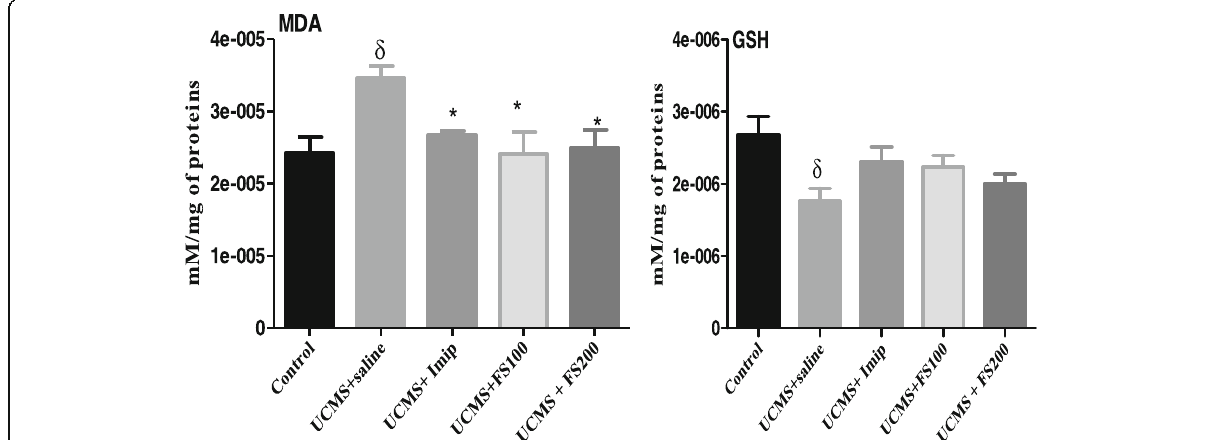
Fig. 12 Effect of F. sycomorus extract on total content of reduced GSH and MDA levels of the brain homogenate before and after unpredictable chronic